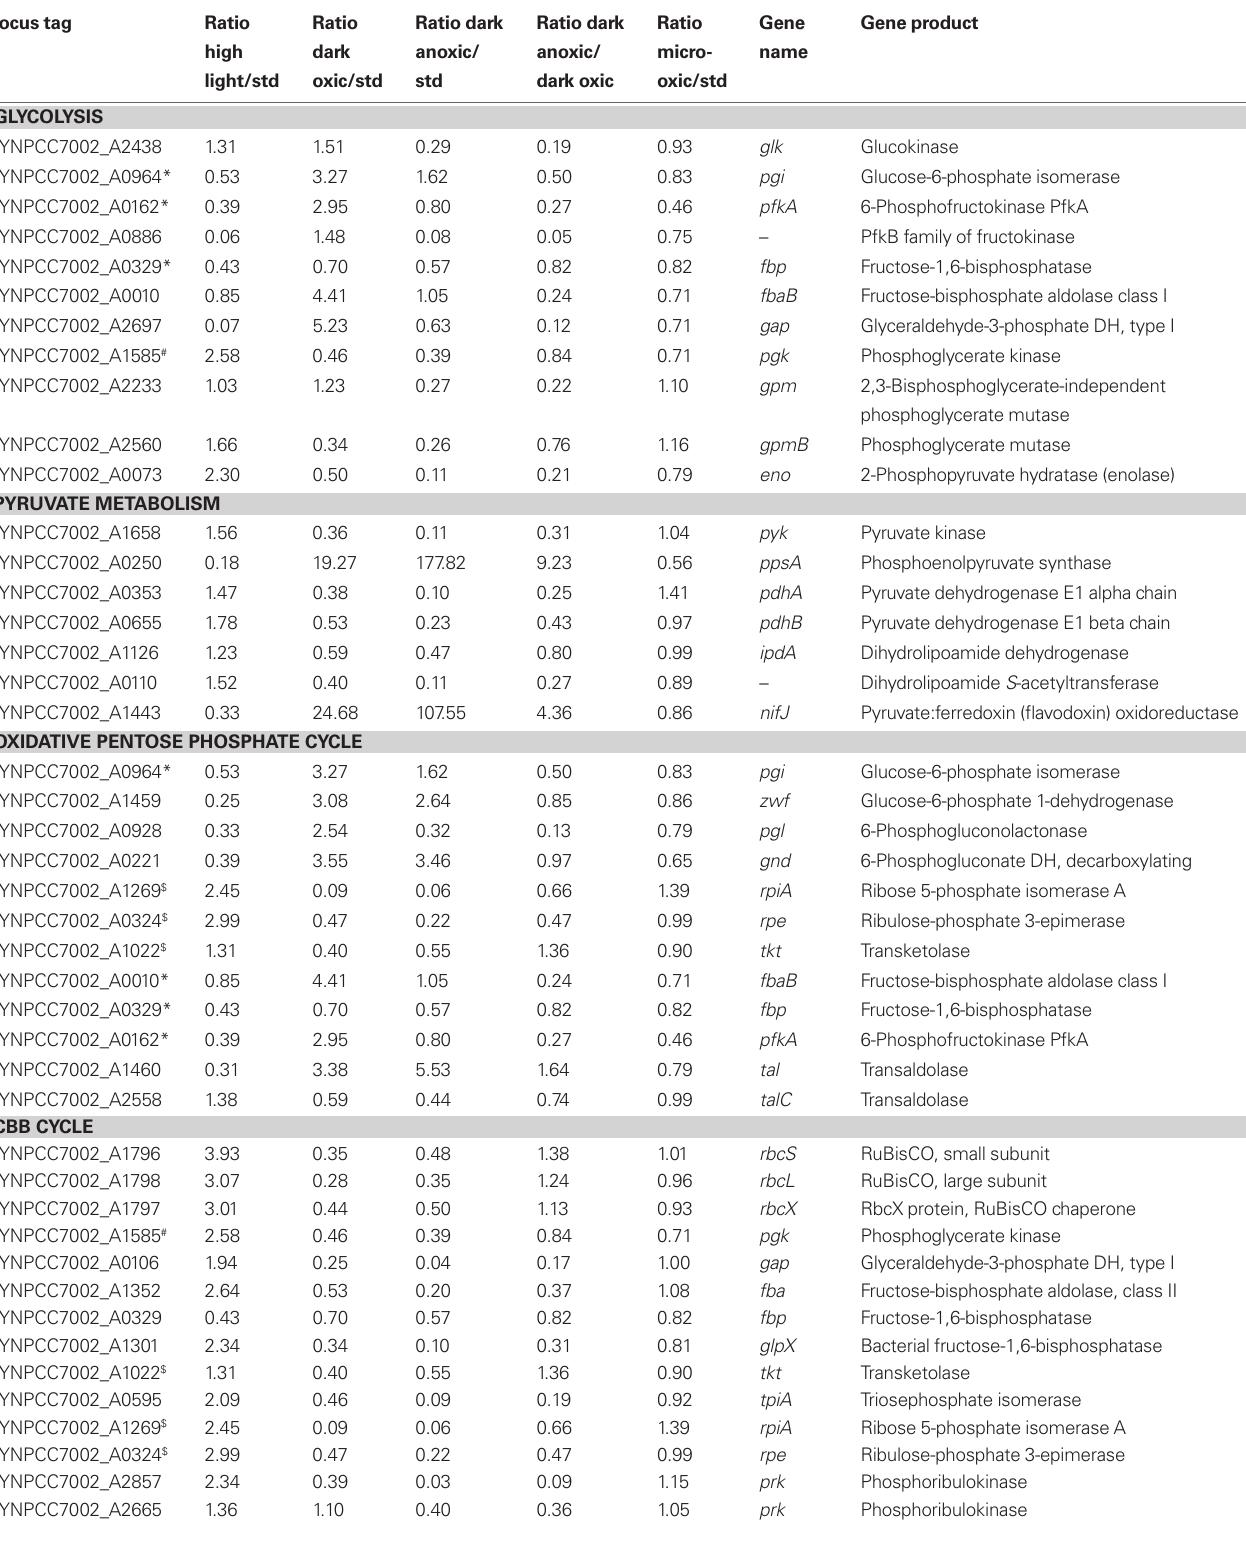
Table 3 | Changes in the transcript level for genes of selected metabolic pathways. Locus tag ratio